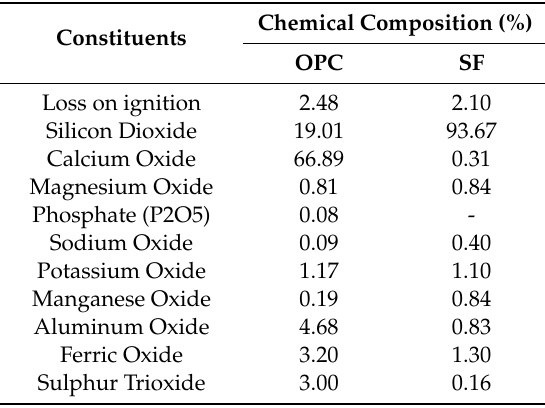
Table 2. The chemical composition of OPC and